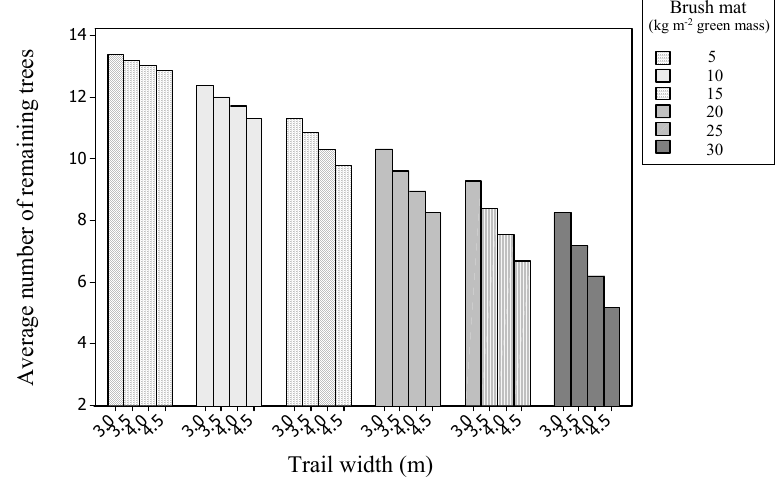
Figure 2. Average number of trees (located within the area covered by a one-half 10-m radius sweep of a 10-m-long machine boom) with brush available for bioenergy use for varying trail widths after allocating required brush mat amounts for trail protection. All trail spacings combined.